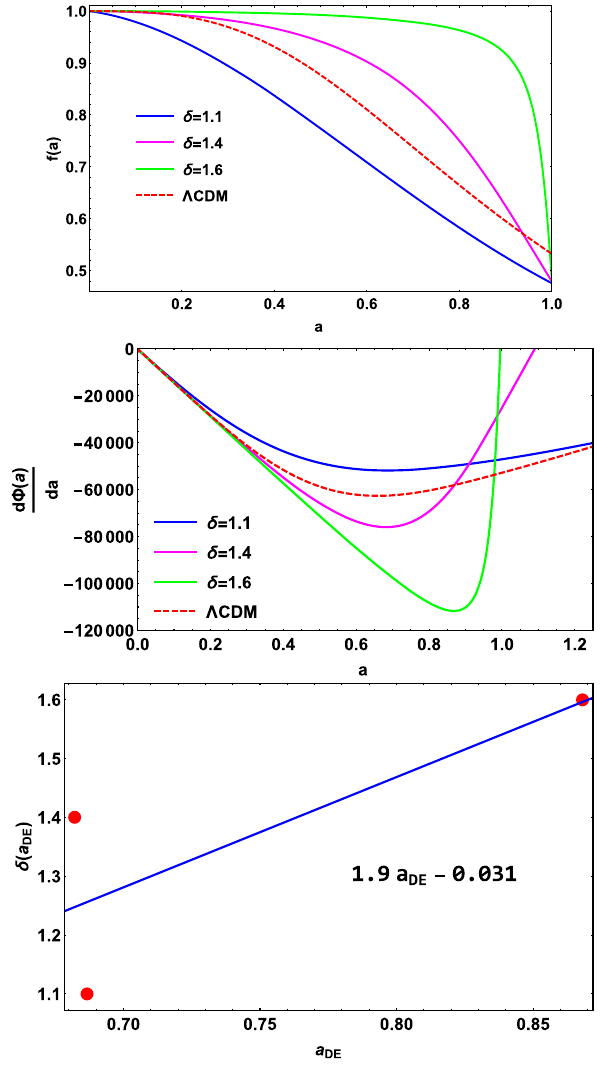
Fig. 2 Topleftpanelshowstheevolutionofgrowthrate f ( a ) ,topright panel shows the rate of change of configurational entropy ( d Φ( a ) the lower panel shows the best fit relation between the non-additivity parameter δ and the scale factor a DE at which d Φ( a ) The plots are drawn for A = 10